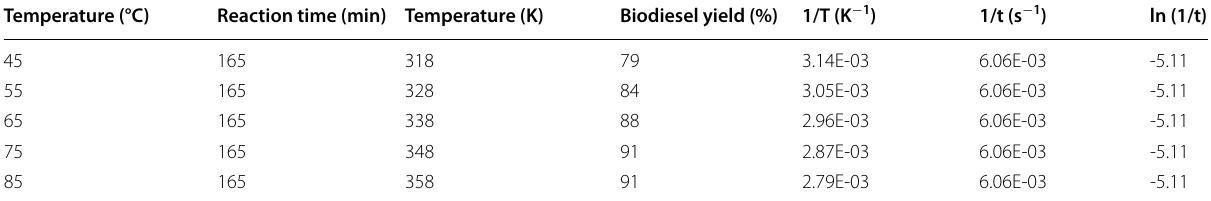
165 min; Activation energy ( E a ) =